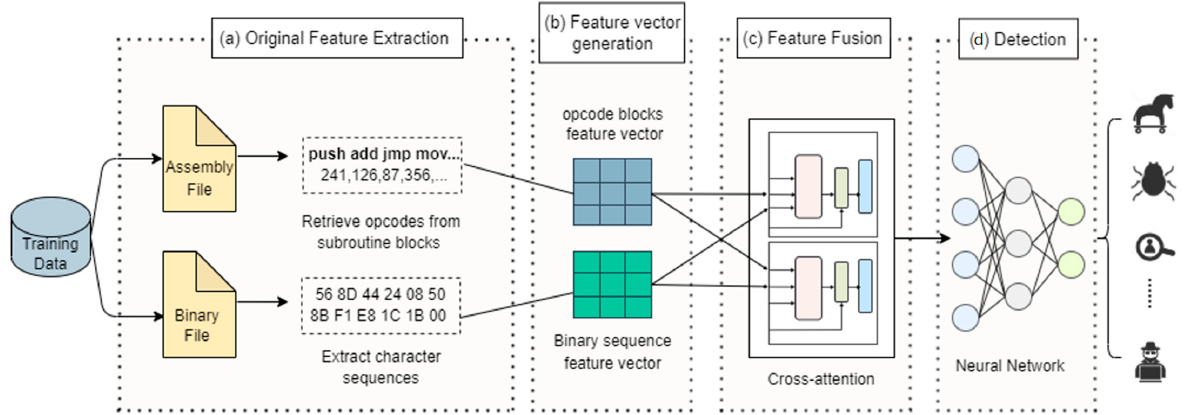
Figure 1. Architecture of the framework. Our framework is made up of four modules: ( a ) original feature extraction module, ( b ) feature vector generation module, ( c ) feature fusion module, and ( d ) detection module.